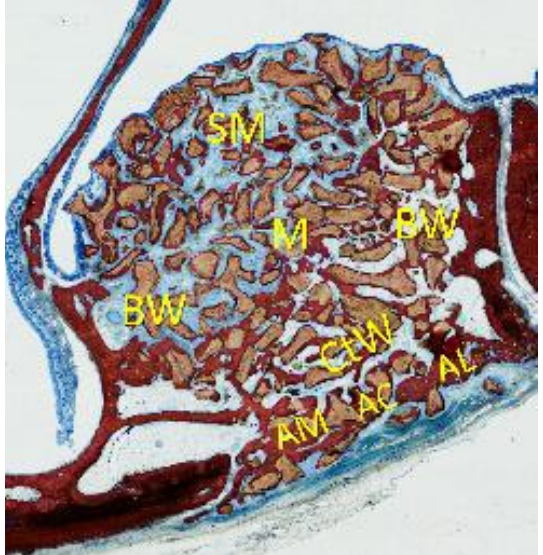
Figure 2. The various regions analyzed in the augmented sinus (BW = bone walls; M = middle; SM = sub-mucosa; CtW = close-to-window) and the antrostomy region (AL = lateral; AM = medial margin; AC = center of the antrostomy).